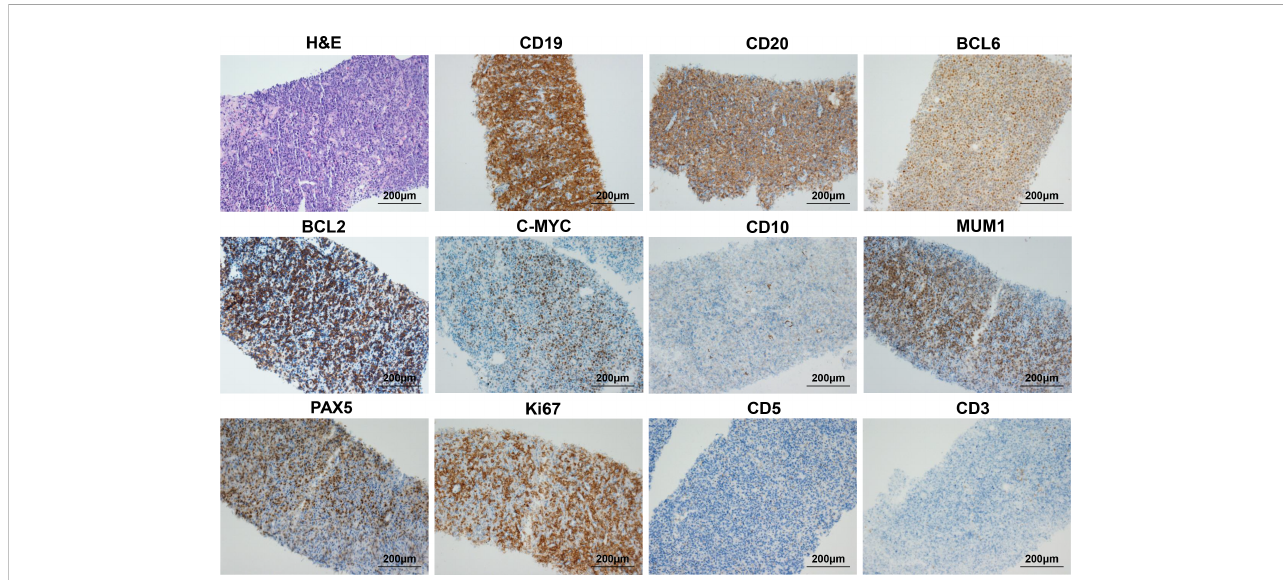
FIGURE 3 Biopsy of right thigh mass showing primary cutaneous diffuse large B cell lymphoma, leg type (PCLBCL-LT) with c-MYC/BCL2 double-expressor. The fi rst image is H&E staining of thigh mass (original magni fi cation 200×), and the other images are IHC staining for CD19, CD20, BCL6, BCL2, C-MYC, CD10, MUM1, PAX5, Ki-67, CD5, and CD3 (original magni fi cation: